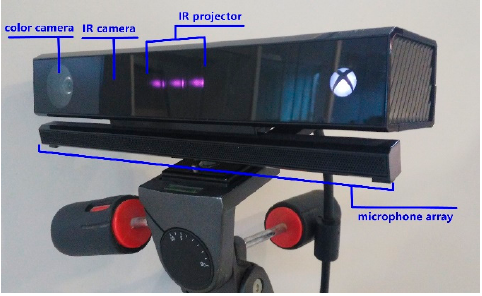
Figure 1. Kinect v2 sensor working on a photographic tripod. Table 1. Technical specifications of the Kinect v2.